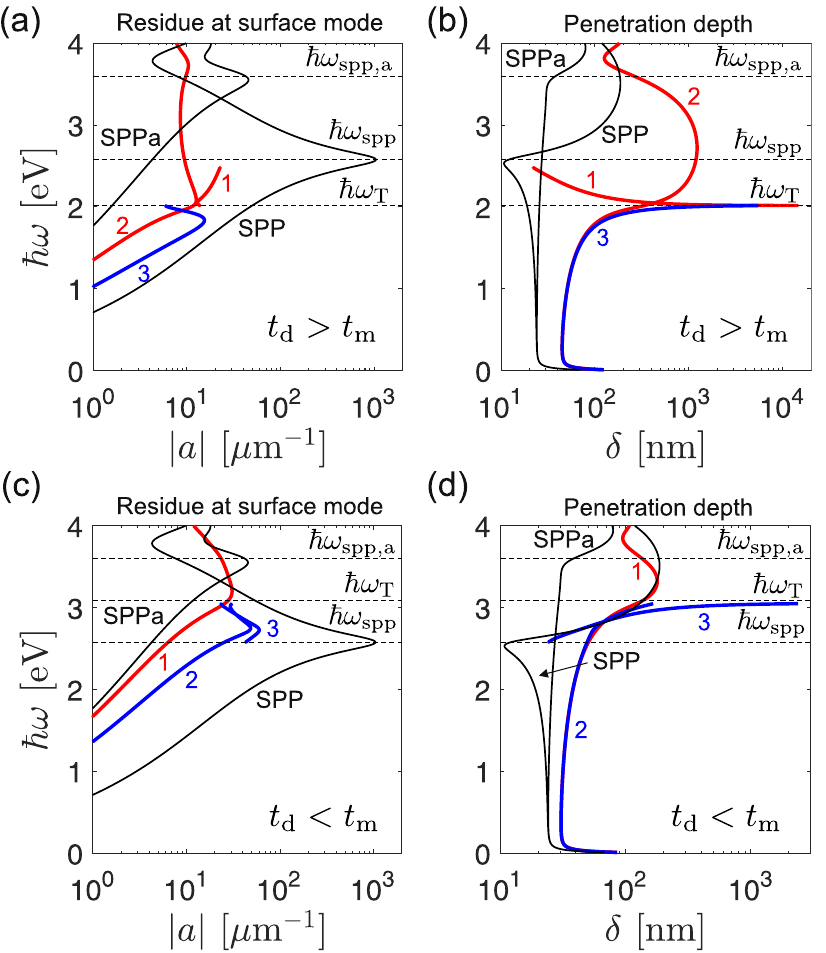
Figure 10. Left panels: residue at the TPM and SPP modes, drawn for the ( a ) t d > t m and ( c ) t d < t m examples, respectively. Righ panels: penetration depths into the superlattice for ( b ) t d > t m and ( d ) t d < t m examples, compared with the corresponding SPP penetration depth. SPP and SPPa stand for the ε d − ε m and ε a − ε m interface SPPs,